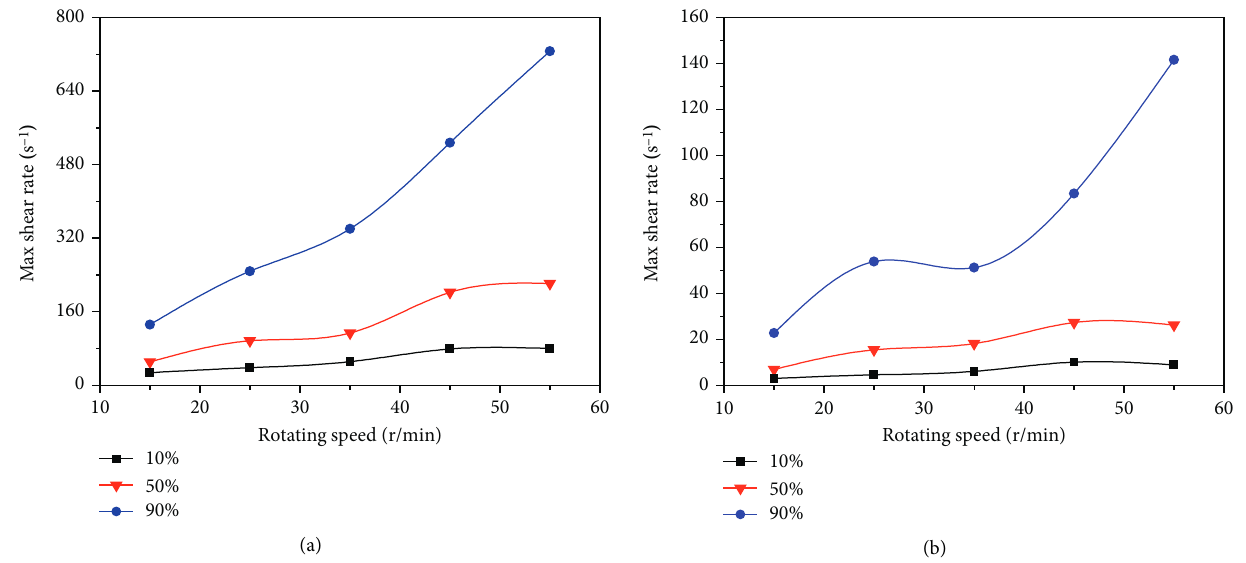
Figure 7: Influence of rotor rotational speed on the maximum shear rate (a) and stretching rate